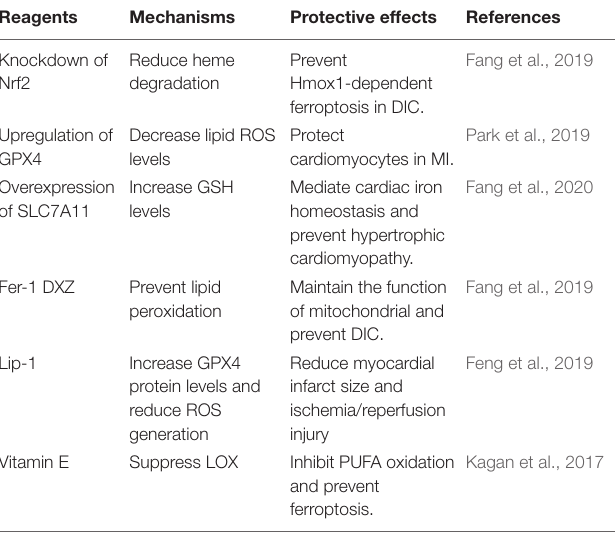
TABLE 3 | Application of ferroptosis for treatment of cardiovascular